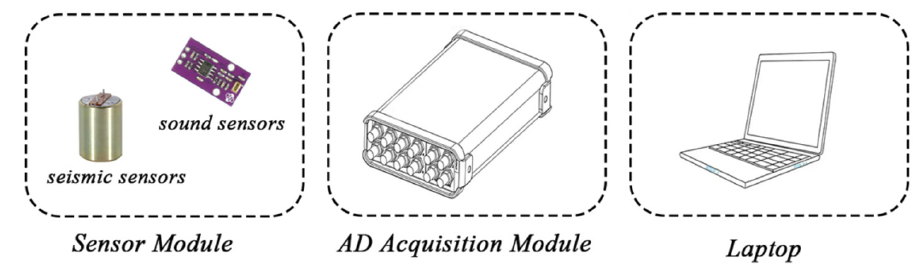
Figure 6. Experimental hardware.